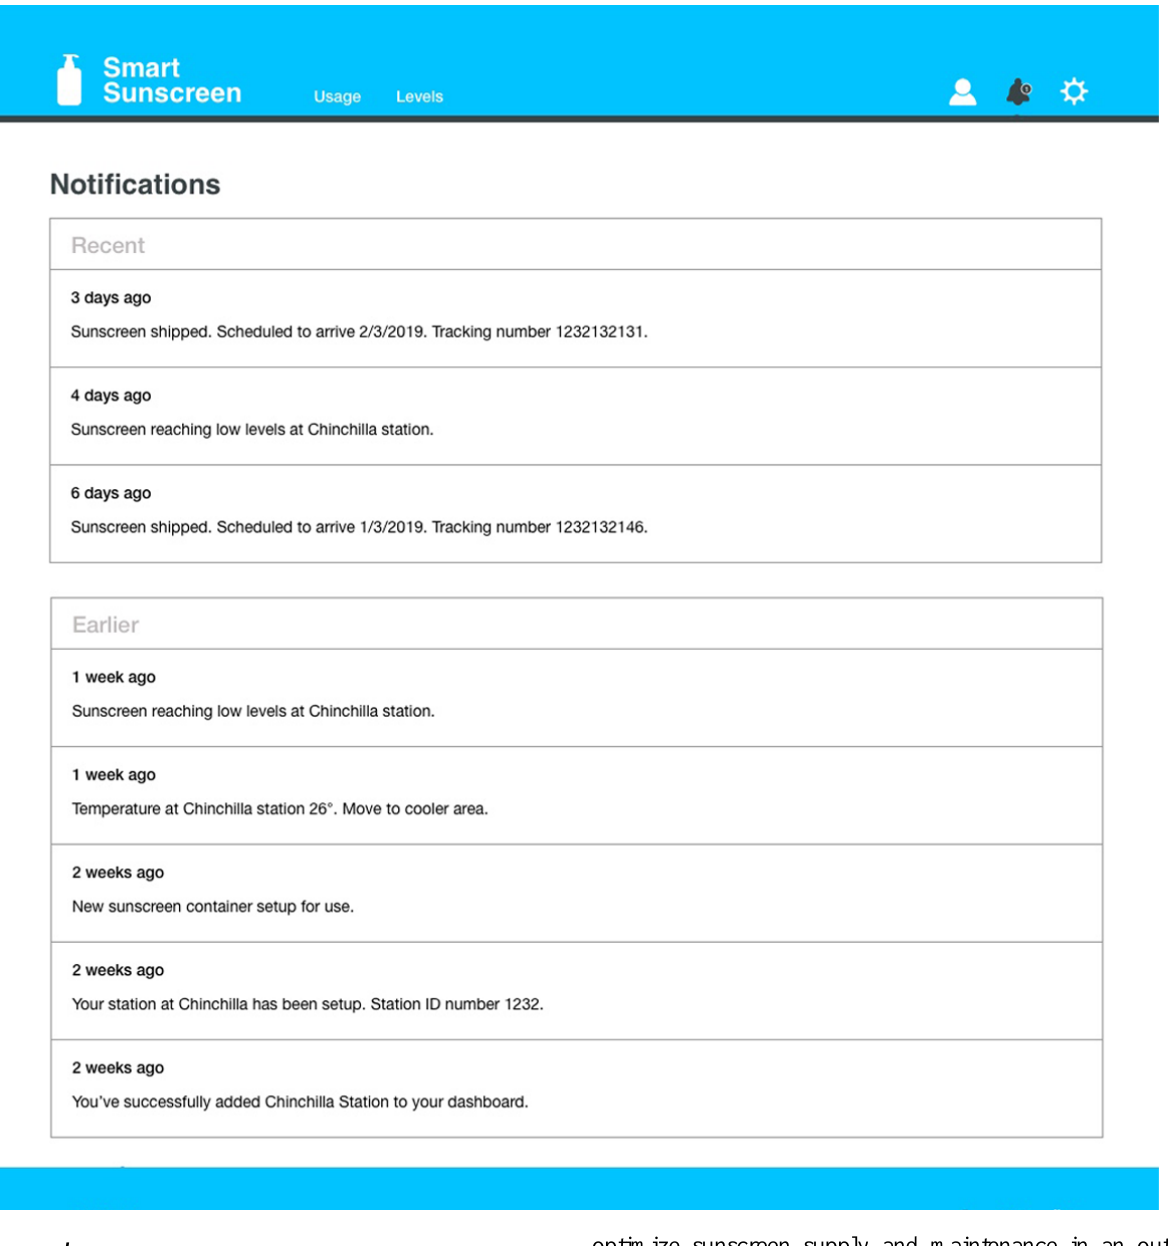
Figure 9. Smart sunscreen station dashboard showing notifications and